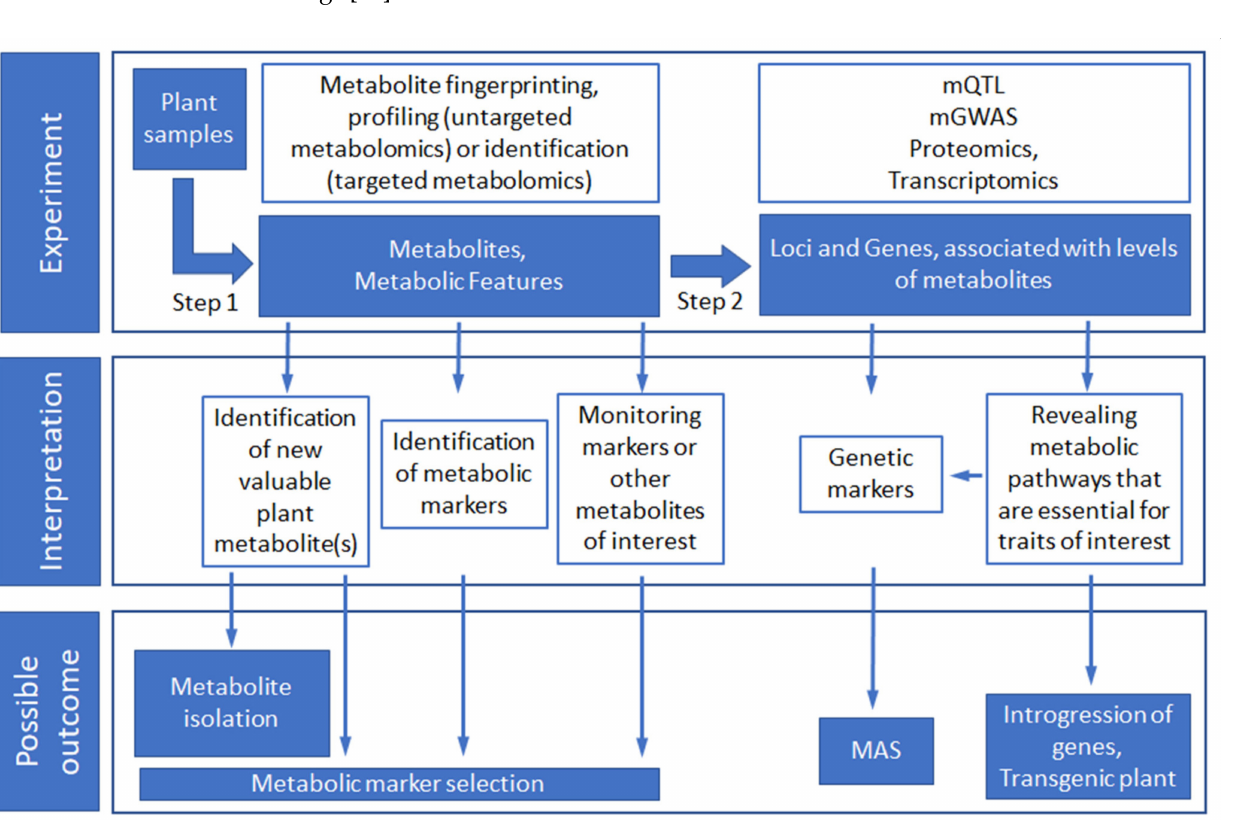
Figure 2. A general scheme of metabolic studies and their integration with QTL mapping and GWAS. Plant samples (leaves, roots, grains etc.) for metabolomics analysis should be collected with special care (see Section 6.1). Typically, plant samples are collected from different crop accessions, or the same accessions grown under different conditions, or samples are collected at different growth stages. In the first step, the metabolomics research methods are applied. The results of such studies are usually the determination of metabolites or metabolic features (see Section 6.1) with different concentrations between the samples. These metabolites can then be monitored as metabolic markers of agronomically important traits or as valuable traits by themselves. (see Section 7). Step 2 assumes integration of the genetic data. The metabolite concentrations obtained in the first step can be used as quantitative traits for QTL mapping analysis (which requires defined breeding protocol for generation of plant samples) or GWAS (which requires substantial number of genetically diverse plant samples of the cultivar of interest). It results in the identification of metabolic QTLs. Then, metabolic QTLs can be used for the development of genetic markers and their application for MAS (see Section 9). Also, valuable genes and gene sets can be identified in related and unrelated plant species to improve